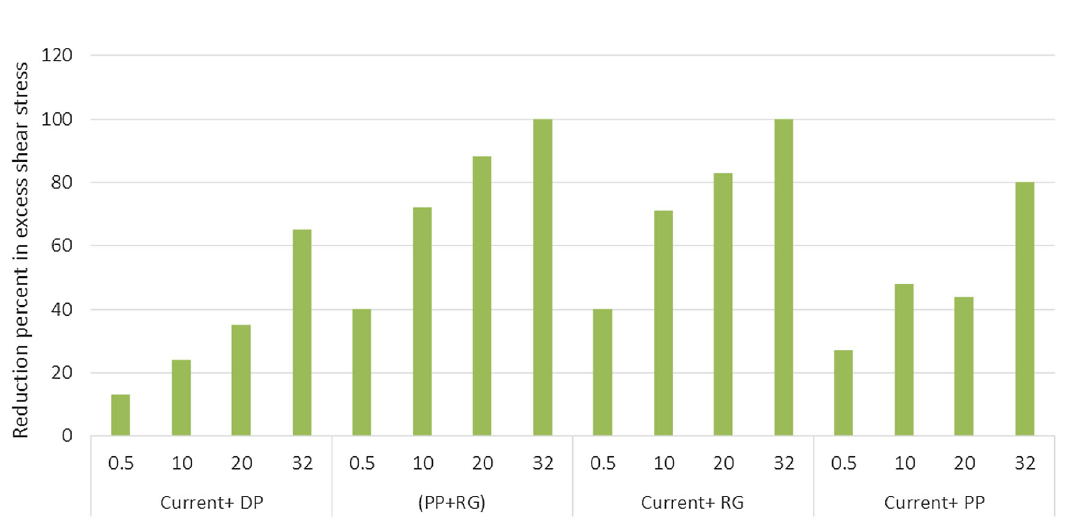
Fig. 7 Reduction percentages in excess shear stress for different soil particle diameters (mm) and by utilizing different types of green infrastructure for 25 years of storm data at Blunn